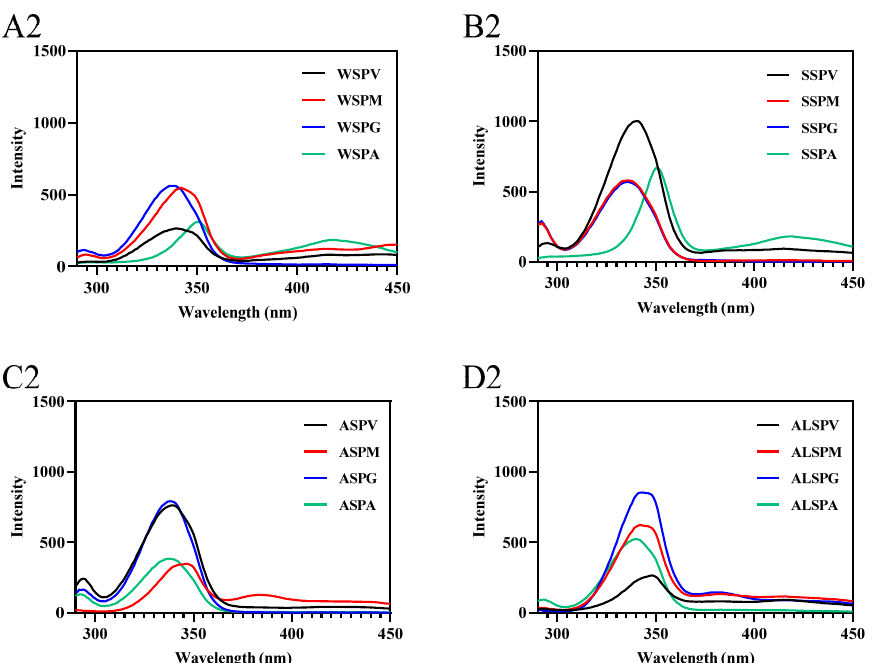
Figure 6. Fluorescence spectra of proteins from different parts of the oyster. ( A – D ), emission spectra of oyster proteins from various parts; ( A1 – D1 ), synchronous fluorescence spectra ( Δλ = 15); ( A2 – D2 ), synchronous fluorescence spectra ( Δλ = 60).